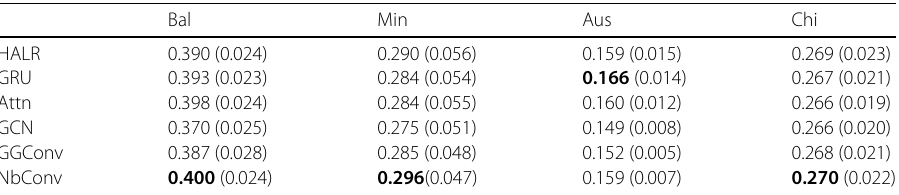
Table 6 Average (standard deviation) of monthly F1 score using C + M for violent crime prediction from Aug. to Dec. 2020 for each city Bal